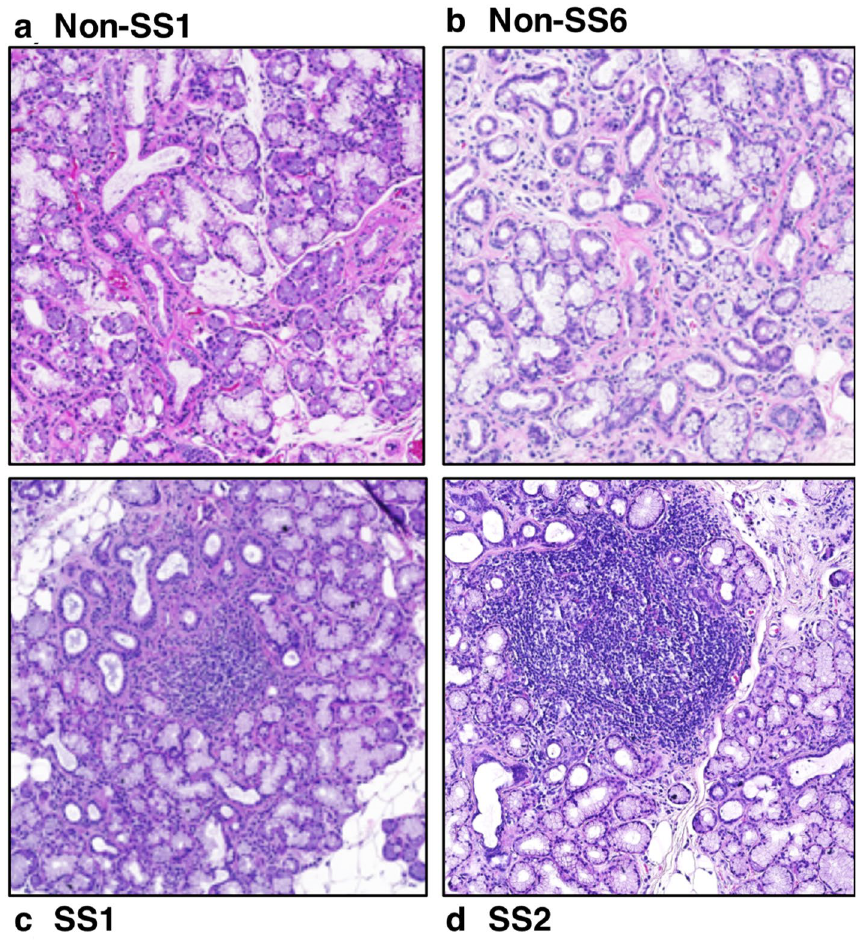
Figure 1. Minor salivary glands biopsies. H&E staining of minor salivary gland biopsies from: ( a ) Non-SS control showing normal appearing salivary gland tissue with few lymphocytic cells, ( b ) Non-SS control with scattered lymphocytes and some interstitial fibrosis, ( c ) SS patient with FS = 1 showing a focal lymphocytic infiltrate and some acinar atrophy and ( d ) SS patient with FS = 2 with a germinal center within a large lymphocytic focal